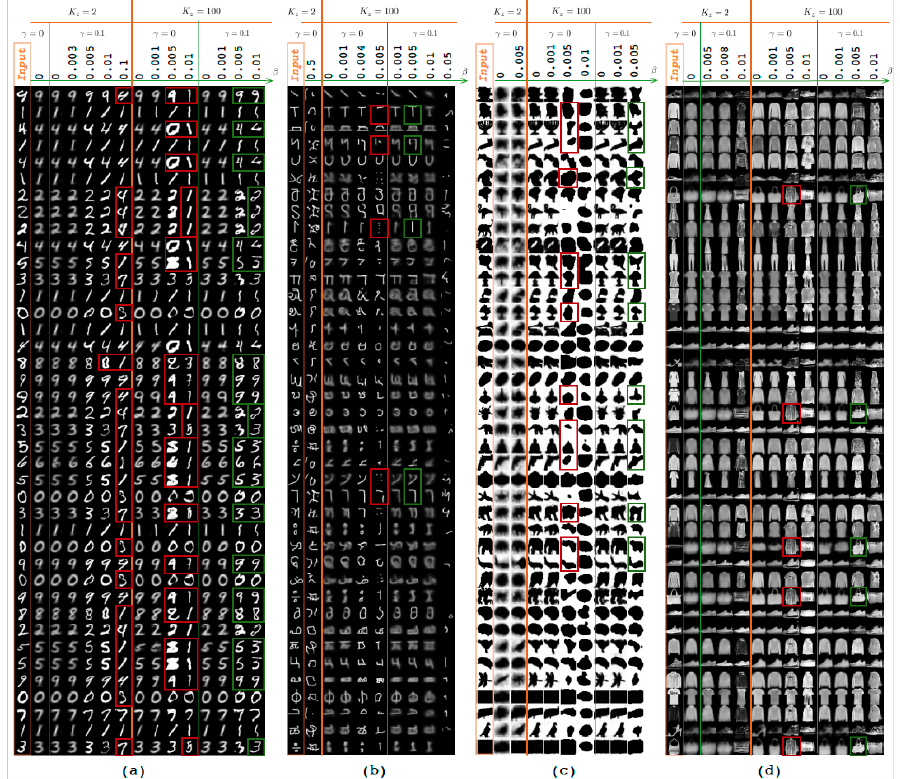
Figure 9. The results obtained for the four databases with different values of β and γ for each of the two latent spaces ( K z = 2 and K z = 100); ( a ) MNIST, ( b ) Omniglot, ( c ) Caltech 101 Silhouettes, ( d ) Fashion